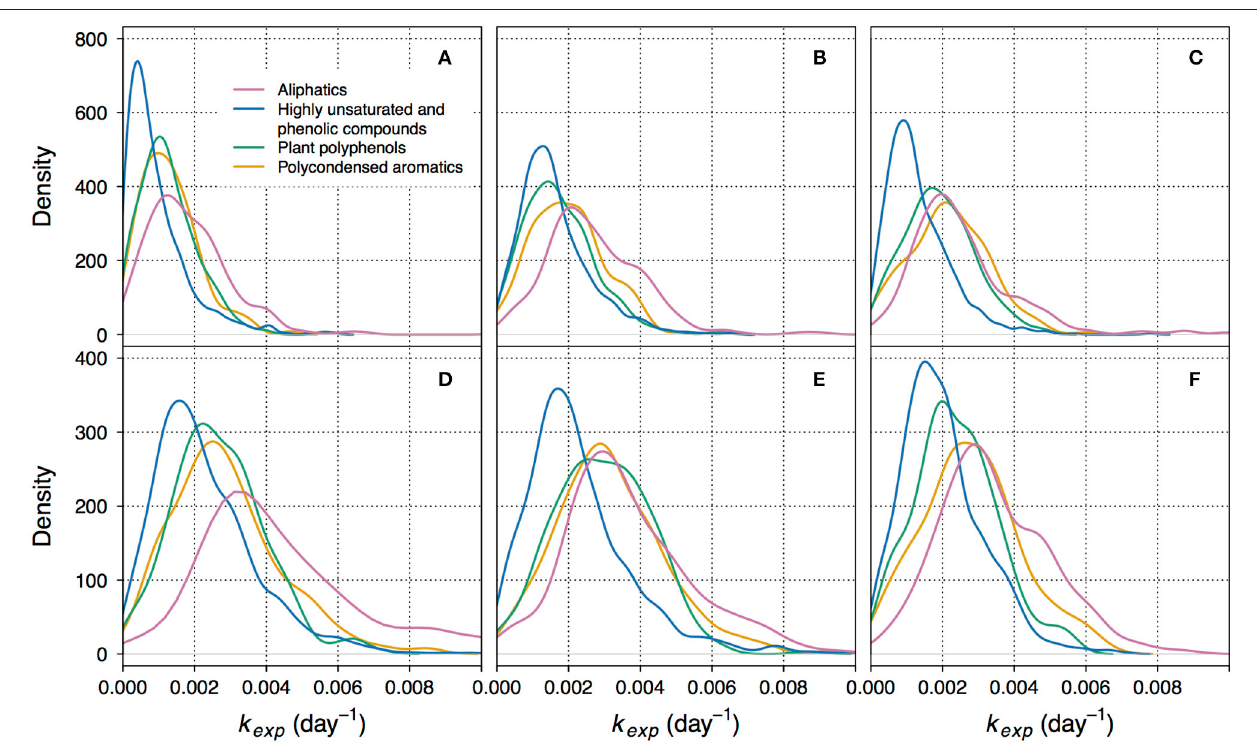
FIGURE 2 | Kernel density plots showing the distributions of decay coefficients k exp within different groups of compounds. Here, kernel density function is a non-parametrically estimated probability density function of k exp . The integral of each function over the range of corresponding k exp equals 1. (A–C) correspond to non-manipulated treatments of lake Lumpen, Ramsjön, and Övre Långsjön, respectively. (D–F) correspond to the UV-manipulated treatments of the same lakes. Note that the Y-axis scale is different for different treatments. One of the duplicate treatments is shown (data from the second duplicate is shown in the Figure